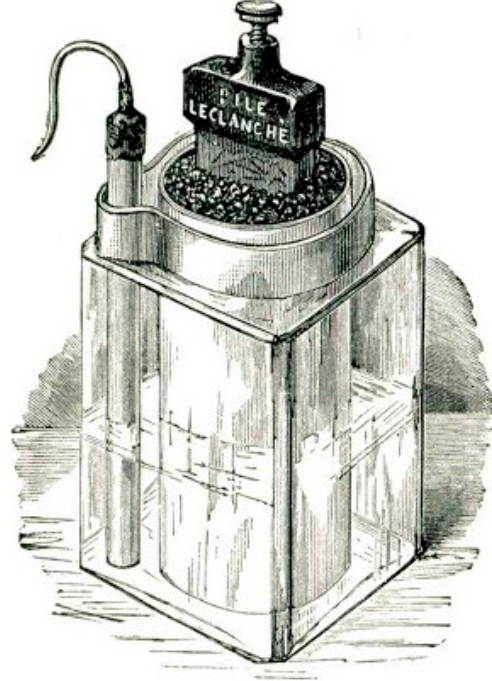
Figure 6. Leclanché wet cell (public